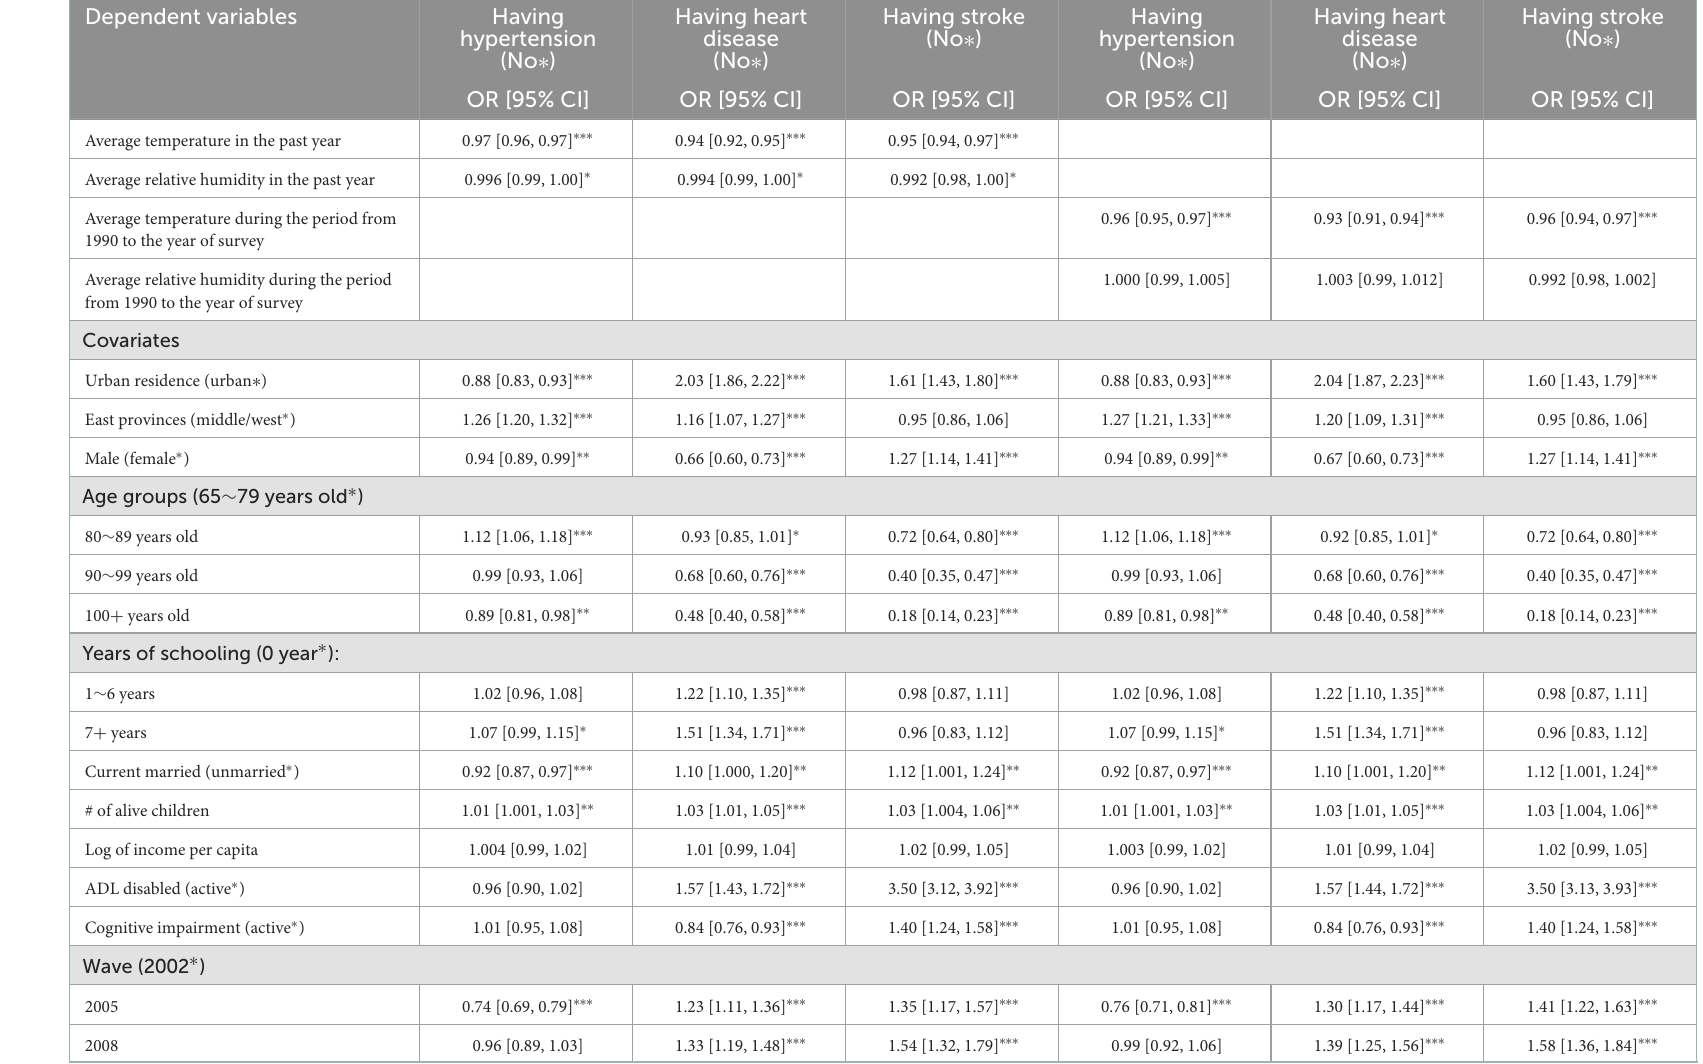
TABLE 2 Effects of temperature and relative humidity on CVD among Chinese older adults aged 65 + during 2002–2018: Odds Ratios (OR) from GEE models. Dependent